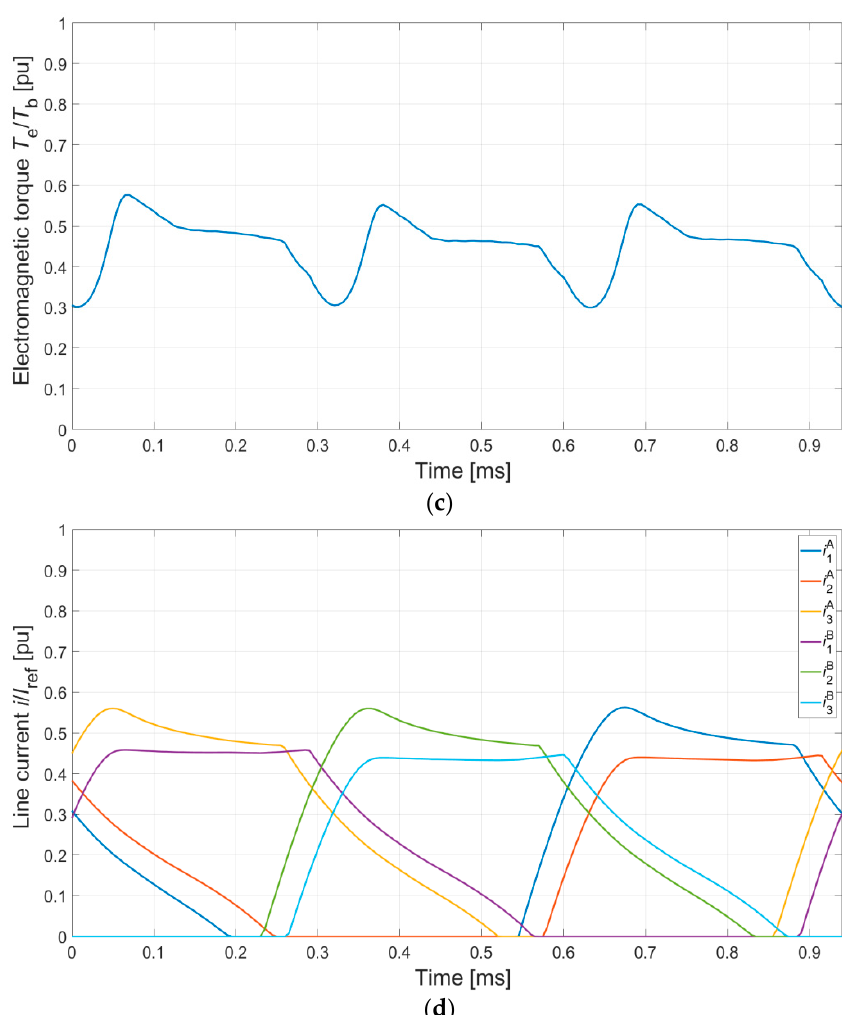
Figure 9. Relative electromagnetic torque and line currents in DCO mode for the DCBLDCM and the DCSRM at asymmetrical control. ( a ) Electromagnetic torque T e for the DCBLDCM. ( b ) Line currents for the DCBLDCM. ( c ) Electromagnetic torque T e for the DCSRM. ( d ) Line currents for the DCSRM.